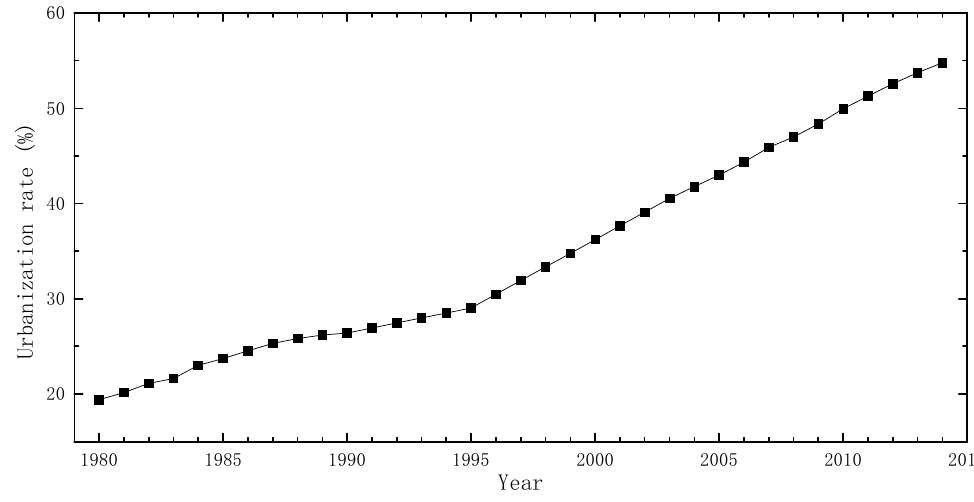
Figure 1. China’s urbanization rate from 1980 to 2014.